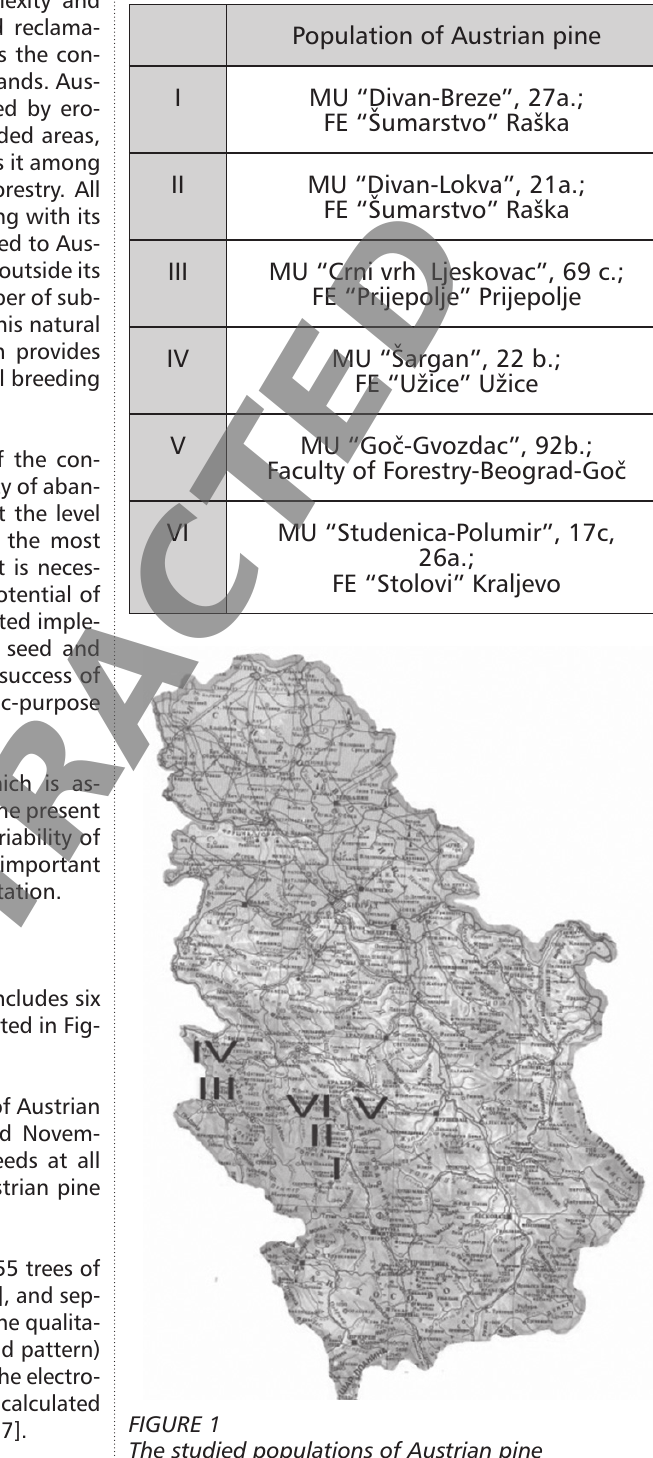
The studied populations of